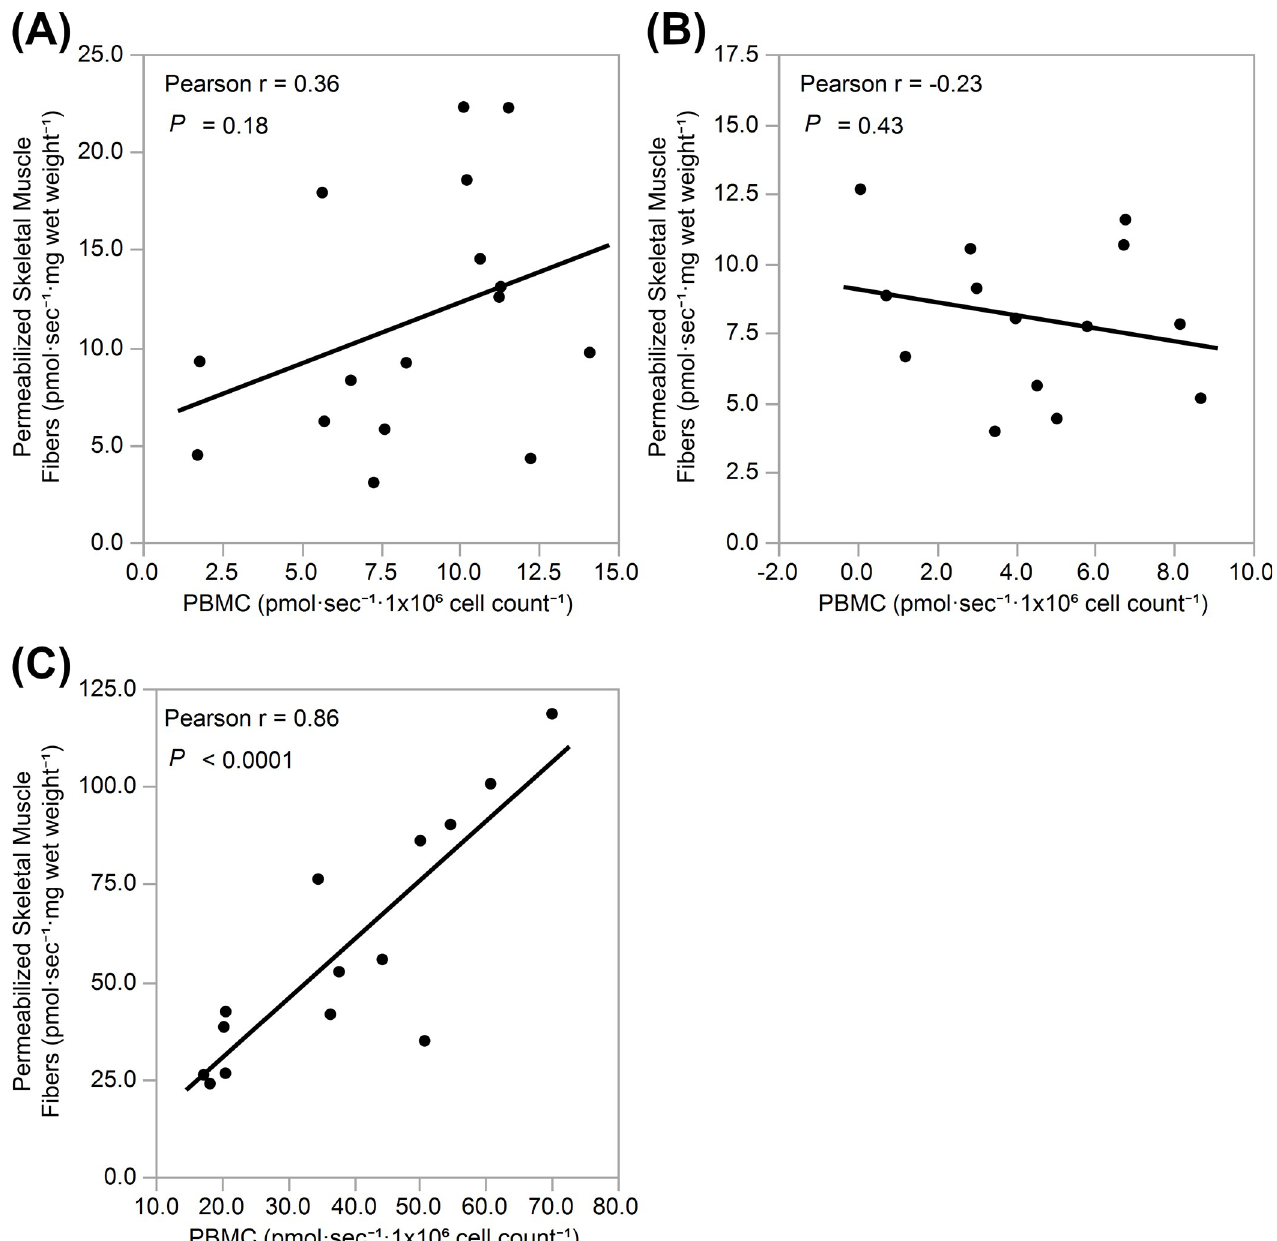
Fig 2. Comparison of PBMCs and permeabilized skeletal muscle fiber measures of mitochondrial capacity. Relationships of maximal rate of oxidative phosphorylation between PBMCs and permeabilized muscle fibers for mitochondrial complexes (A) I (n = 17), (B) II (n = 14), and (C) IV (n = 14). fibers. Comparisons of 16 participants were made for complex I, while comparisons among 14 participants were made for both complex II and IV. Pearson’s correlations were used to com- pare bioenergetics between PBMCs and skeletal muscle fibers (Fig 2). A significant positive relationship was observed between maximal oxidative phosphorylation rates of PBMCs and permeabilized skeletal muscle for complex IV (r = 0.86, P < 0.0001). Conversely, no significant relationships were observed for complex I (r = 0.36, P = 0.18) and complex II (r = -0.23,